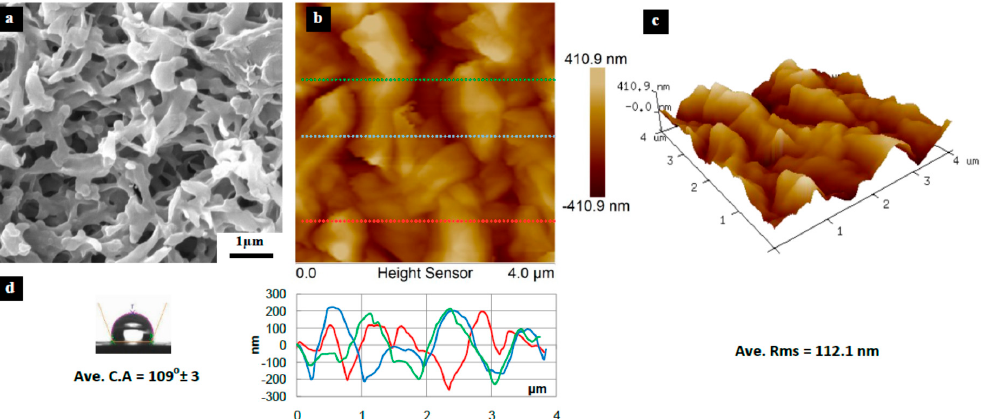
Figure 10. Surface characteristics of as received PVDF 6 substrate (100 nm pore size), ( a ) SEM micrograph; ( b ) 5 × 5 µm 2 AFM image (top) and three section profiles (bottom) with an average RMS equal to 112.1 nm; ( c ) 3D profile for the selected area; ( d ) surface contact angle (CA) with an average equal to 109° ± 3.